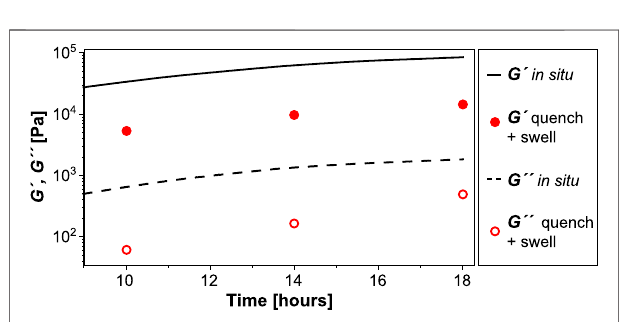
FIGURE 4 | Controlling gelation and polyrotaxane mechanics. Storage and loss moduli values (circular symbols) of gels terminated at 10 h, 14 h, and 18 h are compared with the time sweep data of P 10 C 5 T 25 . The swelling ratios (by weight) of the organogel are mentioned at the speci fi c time points in the gelation